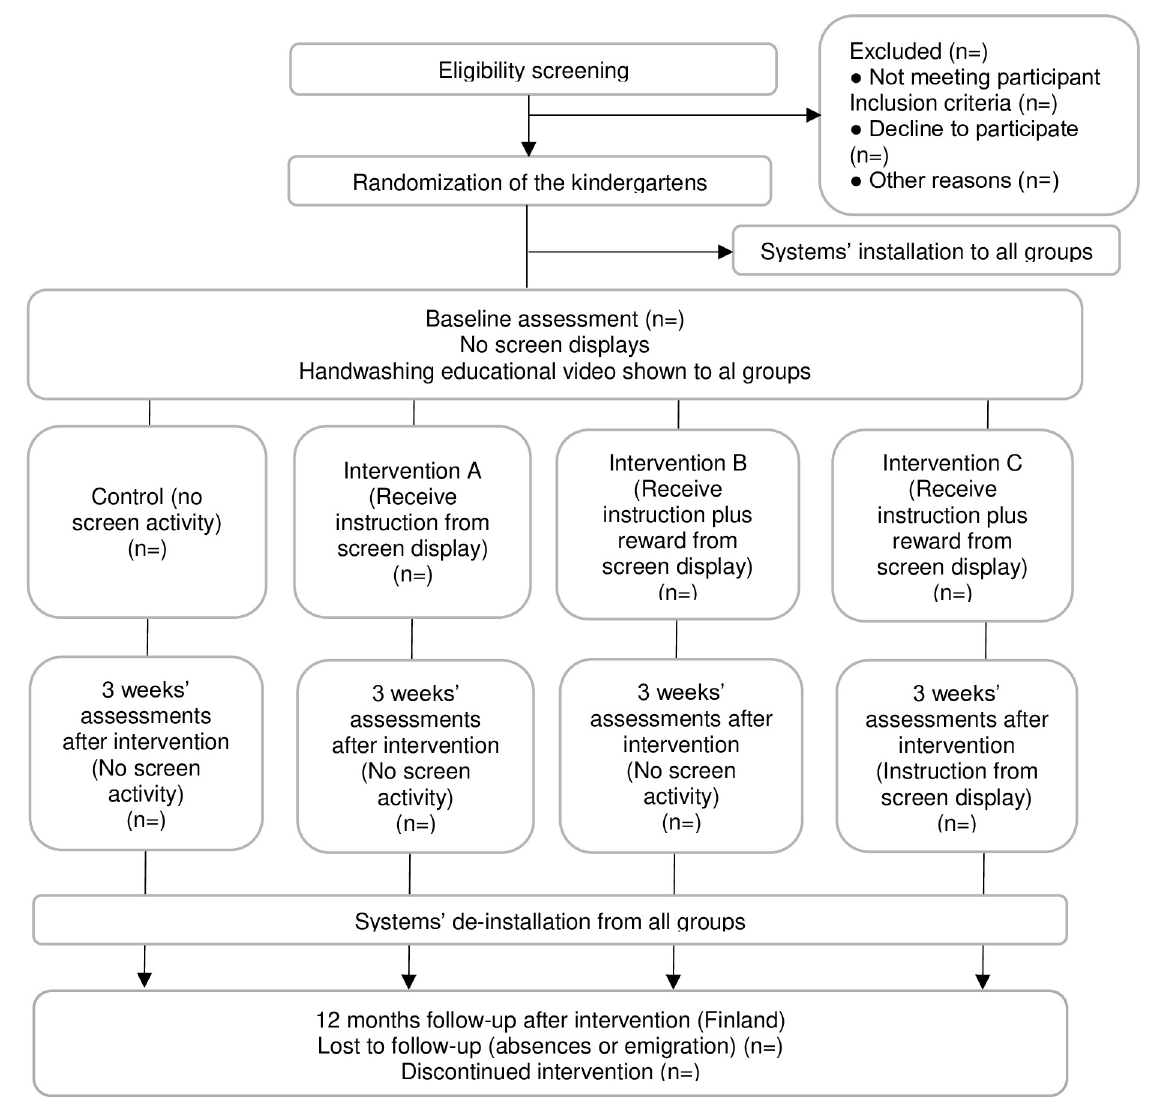
Fig 8. Flowchart of the cluster